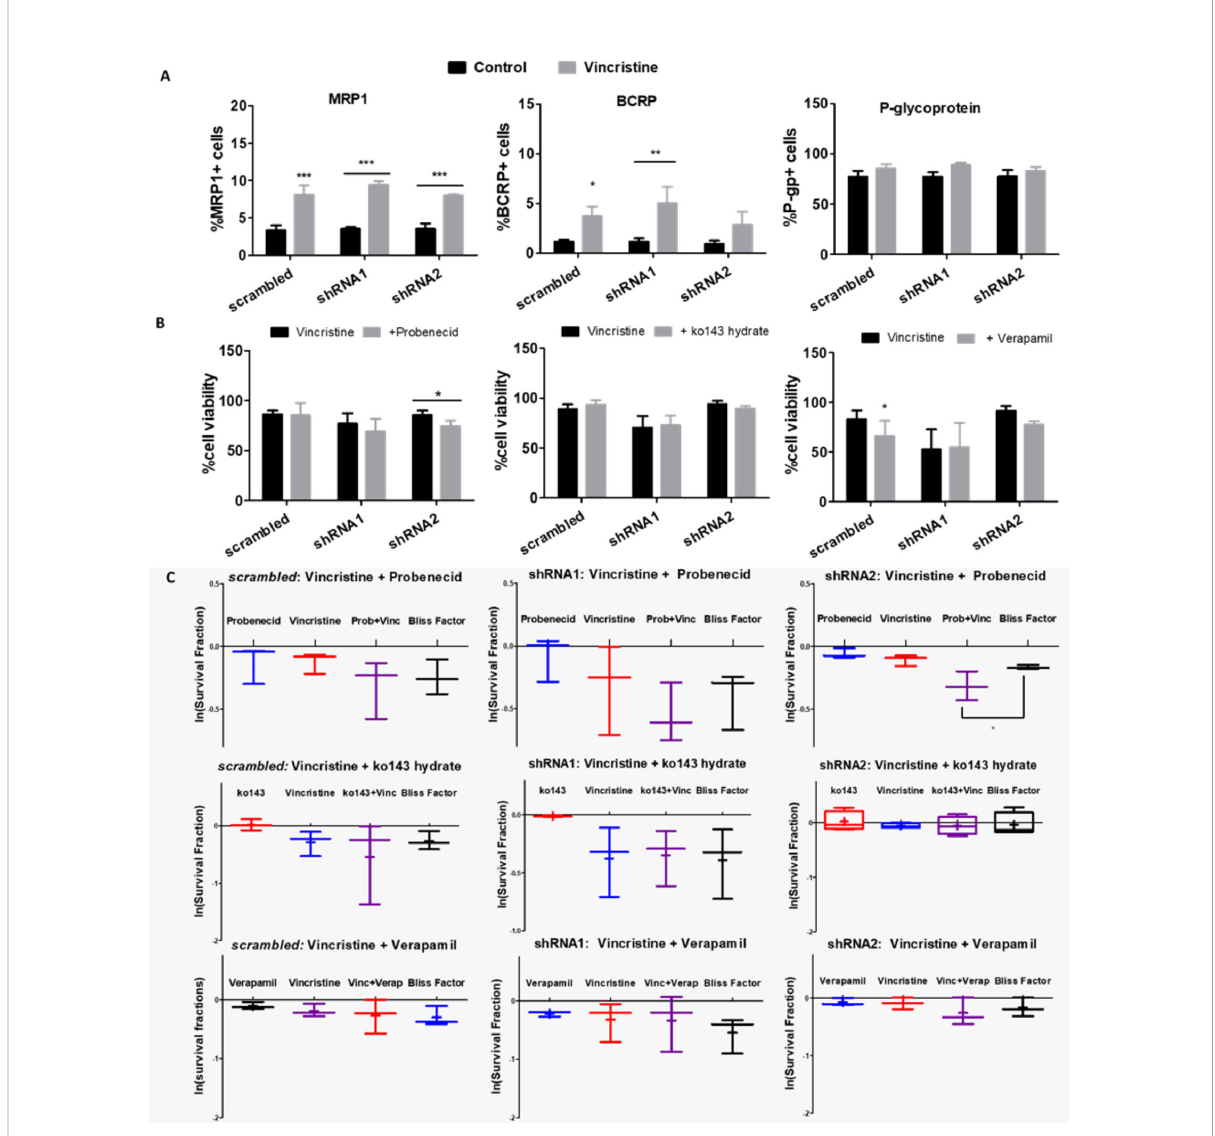
FIGURE 8 Functions of ABC transporters in NB cells differentially expressing A and B isoforms. (A) Flow cytometry measurements of MRP-1, BCRP and P- glycoprotein transporter-expressing ACN cells untreated vs. treated with vincristine (n>=3). (B) Cell viability values of ACN cells treated with vincristine and/or the ABC transporter modulator probenecid (MRP-1), ko143-hydrate (BCRP) or verapamil (P-glycoprotein) (n>=3). (C) Synergy investigation of vincristine combined with ABC transporter modulators in ACN cells using the Bliss Independence method (28), based on the natural logarithm of experimental survival fractions of populations treated with both drugs in combination, compared to the predicted survival fraction called Bliss Factor (n>=3). * p <0.05; ** p <0.01; *** p